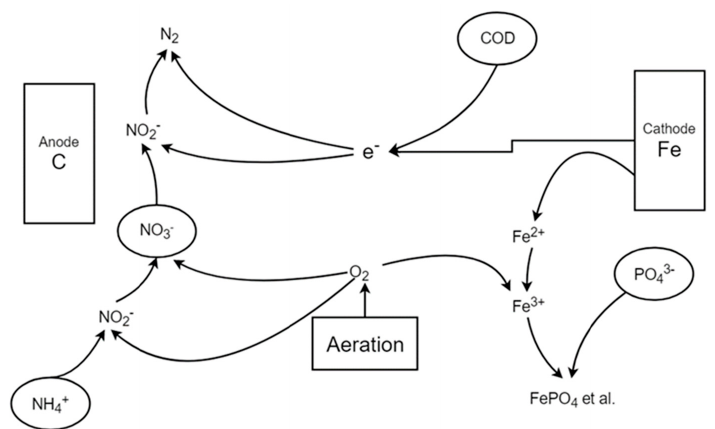
Figure 2. The mechanism of ferric-carbon micro-electrolysis (Fe/C-M/E)-coupled half-way aeration system.